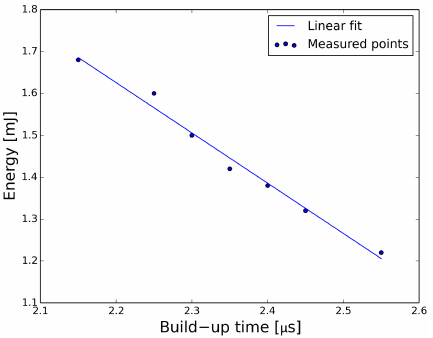
Figure 3. Measured and interpolated pulse energy as a function of the build-up time.